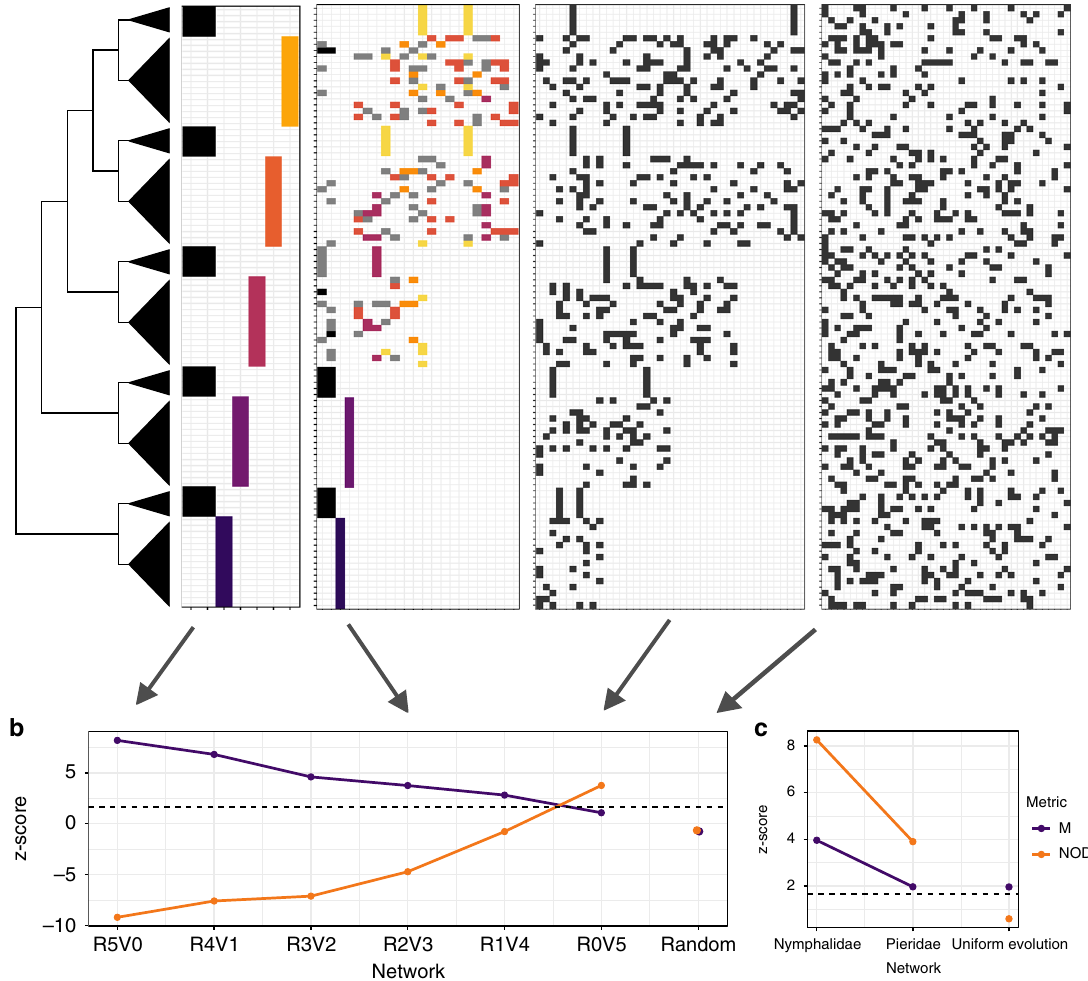
Fig. 1 Structure of networks across simulated scenarios. a Phylogenetic tree of hypothetical butter fl y group where triangle size is proportional to clade diversity. Four of the simulated networks, where each coloured cell represents an interaction between a butter fl y taxon (rows — ordered to match the phylogeny) and a host taxon (columns). Interactions are coloured by module when network is signi fi cantly modular. b Z- score for nestedness (NODF) and modularity (M) for each simulated network, calculated by comparing each estimate to null model expectations (see Methods for more details). The horizontal dashed line indicates the signi fi cance threshold for values higher than expected under the null model. Simulation R5V0 represents the pure radiation scenario (i.e., fi ve radiations) and R0V5 represents the pure variability scenario, with intermediate levels of both in between them. “ Random ” is the network where interactions were assigned randomly. c Z- score for empirical networks and simulated network produced by the uniform evolution